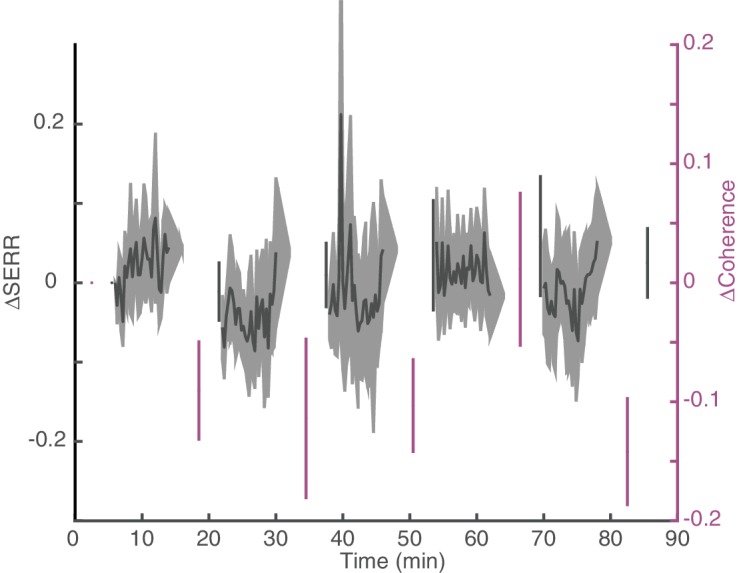
Dynamics of changes in connectivity for control sessions.Replication of Figure 5B for control (no stimulation) sessions. Dynamics of change in SERR and theta coherence with respect to baseline connectivity across all experiments (shaded area show standard error).10.7554/eLife.31034.020Figure 5—figure supplement 1—source code 1.Change in SERR and coherence measurements for control sessions across time.10.7554/eLife.31034.021Figure 5—figure supplement 1—source data 1.SERR and coherence measurements for control sessions across time.